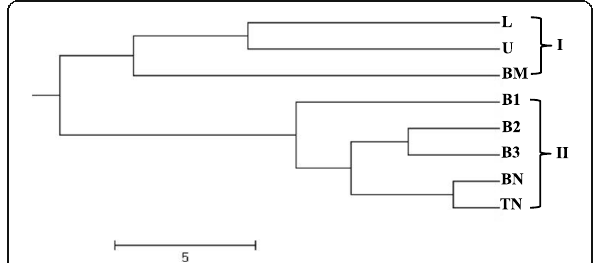
Fig. 7 UPGMA clustering of I . griffithii populations based on